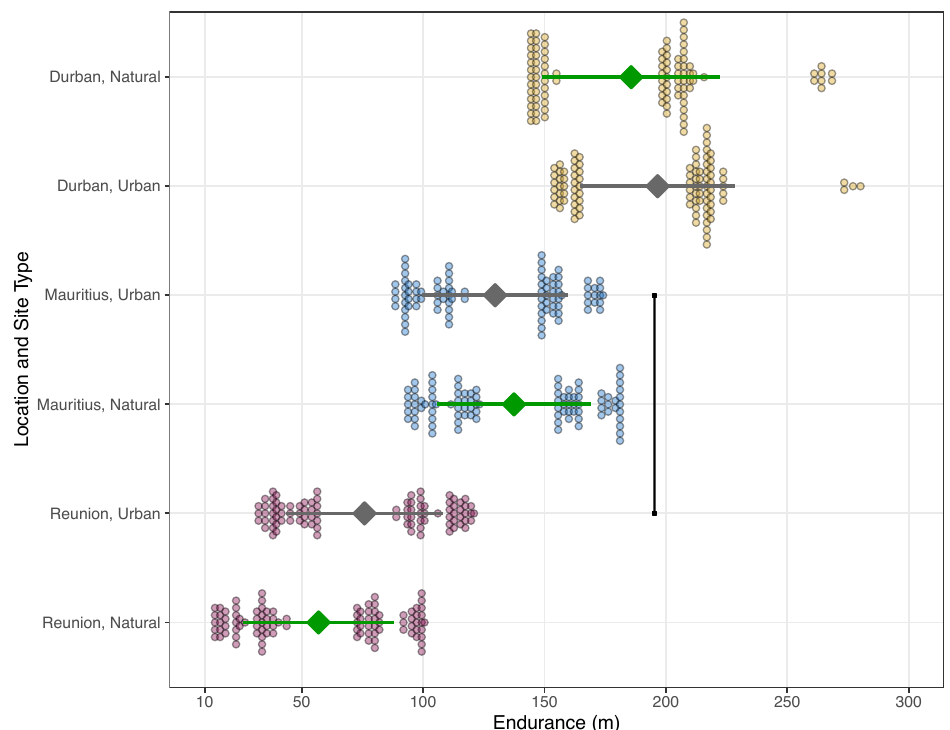
Figure 2. Endurance, in distance (m), for guttural toads ( Sclerophrys gutturalis ) from natural (gray diamonds) and urban (green diamonds) sites in Durban (yellow points), Mauritius (blue points), and R é union (burgundy points). These data were predicted from our LMM, and data points are shown as the means (triangles) ± standard error ( SE ; horizontal lines). Significant differences along the hypothesized guttural toad invasion routes are highlighted using a black line with squares at the ends. P -values for other comparisons are presented in Table